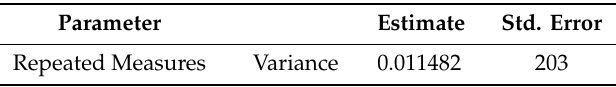
Table 10. Estimates of Covariance Parameters a